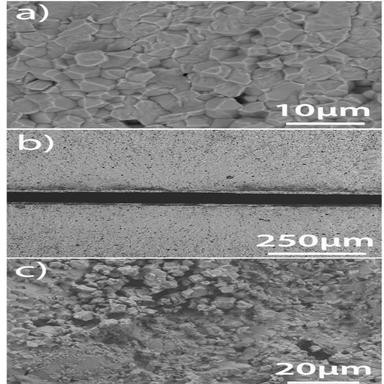
Characteristic features found in the fracture surfaces of specimens of both thicknesses of material PZT. SEM micrographs of Au-coated surfaces of specimens with average values of fracture strength. a) Microstructure of the material. b) Both parts of a specimen of 1 mm thickness with 76 MPa strength c) Critical defects. Differential sintered zone in a specimen with 74 MPa strength.